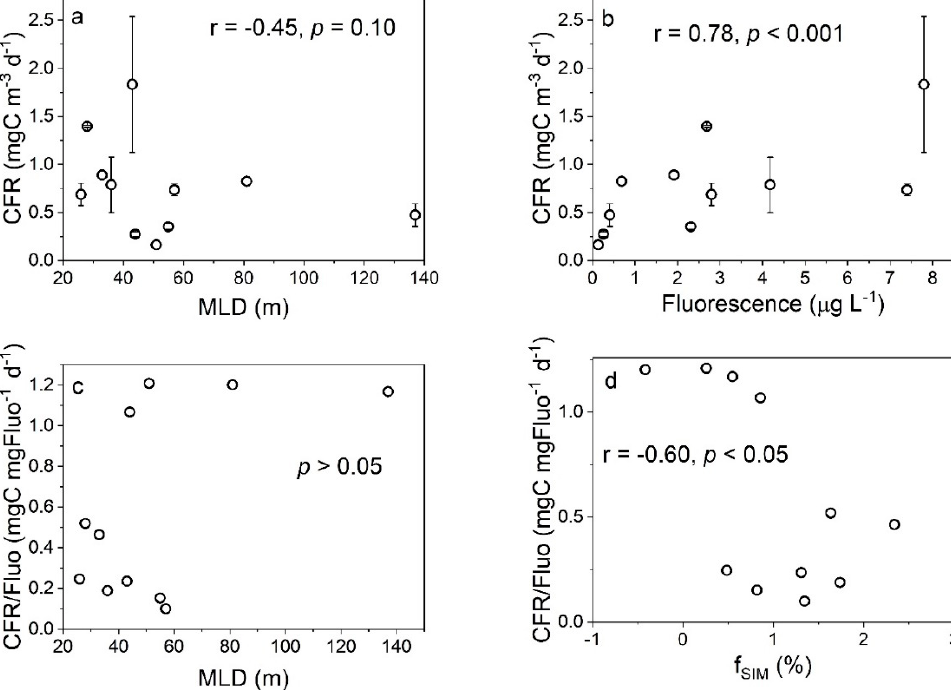
Figure 9. The relationships between the CFR and the MLD ( a ) and phytoplankton biomass (expressed as fluorescence) ( b ) and between the biomass-normalized CFR and the MLD ( c ) and f SIM ( d ) in surface